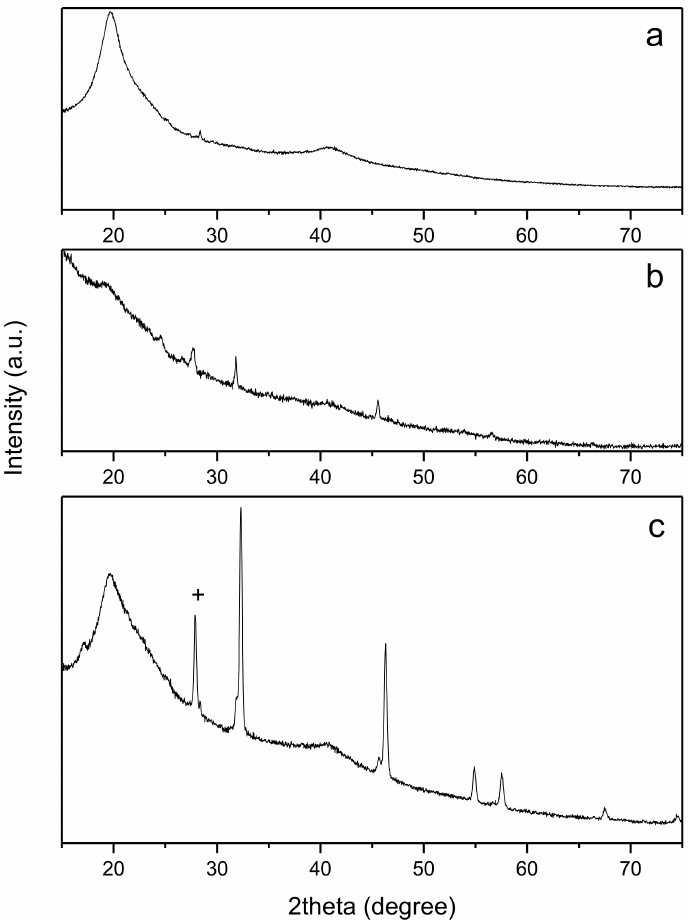
Figure 1. The XRD patterns of pure PVA film ( a ), PVA/LiCl electrolytic film ( b ) and PVA/AgNO 3 electrolytic film ( c